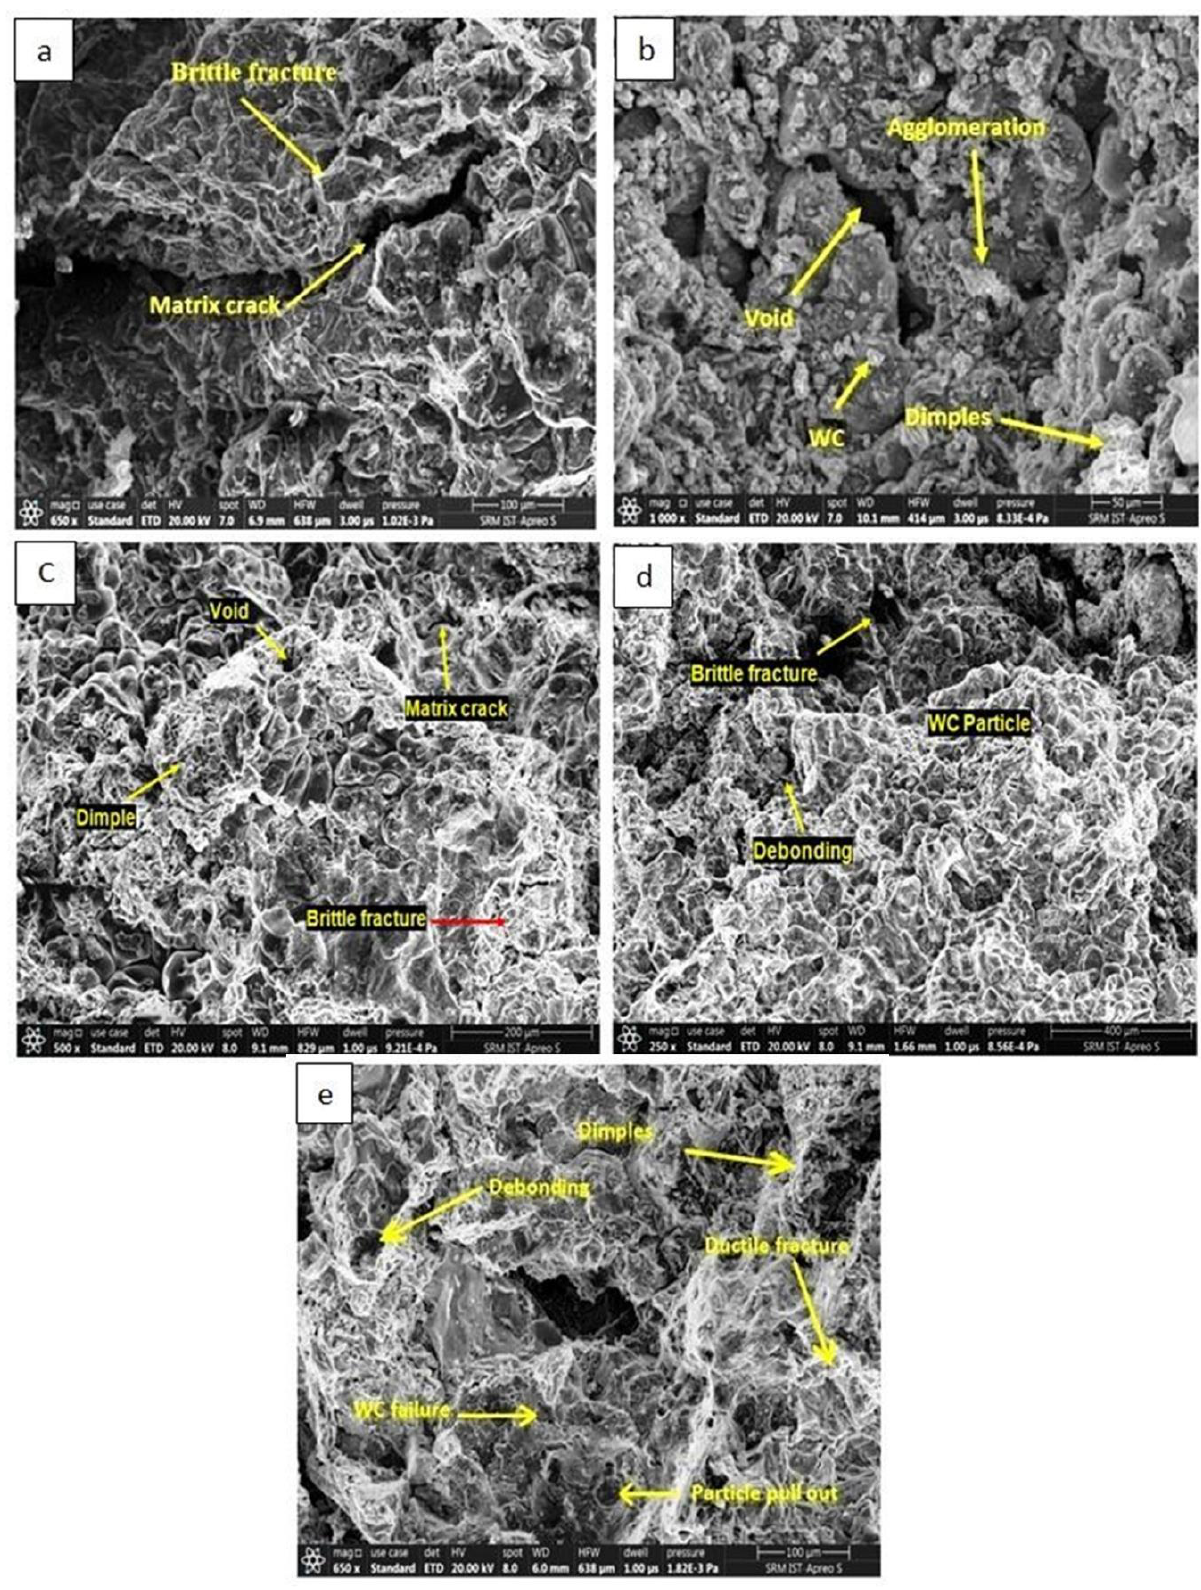
Figure 7. SEM Fractography image of ( a ) non aged and aged at ( b ) 150 °C, ( c ) 250°, ( d ) 350 °C and ( e ) 450 °C specimen.